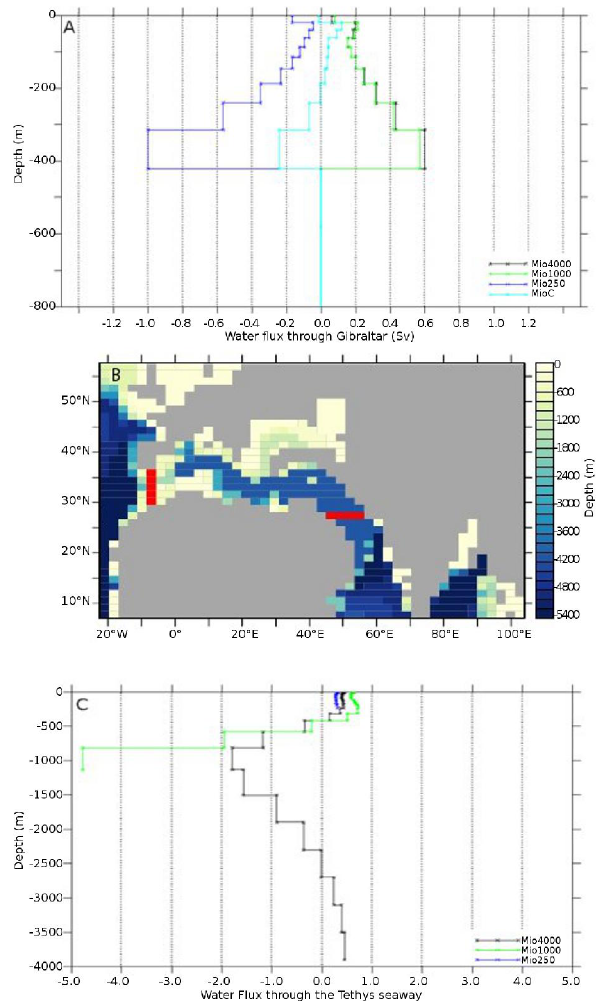
Fig. 4. (A) Zonal water transport through Gibraltar seaway (Sv). Positive values indicate eastward transport; negative values indicate westward transport. (B) Focus on bathymetry used in open Tethys seaway experiments. Red segments indicate grid points where wa- ter transports have been computed. (C) Meridional water transport through eastern Tethys seaway (Sv). Positive values indicate north- ward transport; negative values indicate southward